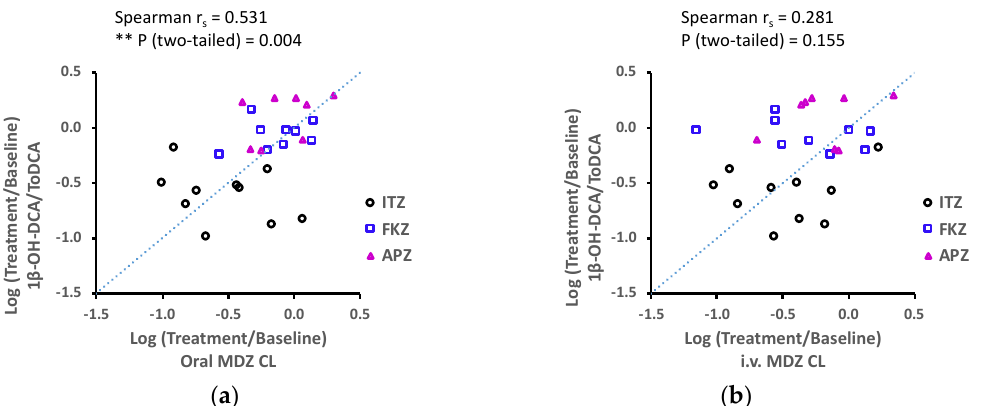
Figure 6. Spearman correlation between changes of the urinary metabolic ratio of 1 β -OH-DCA/ToDCA and orally ( a ) and i.v. ( b ) administered MDZ clearance before (baseline) and after the repeated administration of ITZ (100 mg od for 6 days), FKZ (50 mg od for 14 days), and APZ (1 mg od for 9 days).